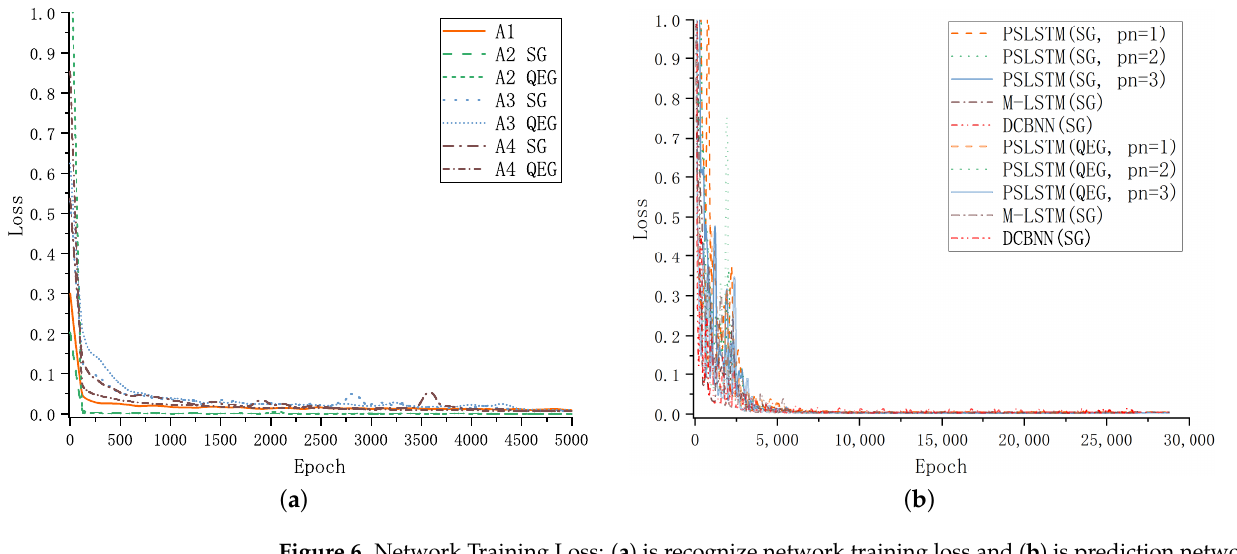
Figure 6. Network Training Loss: ( a ) is recognize network training loss and ( b ) is prediction network training